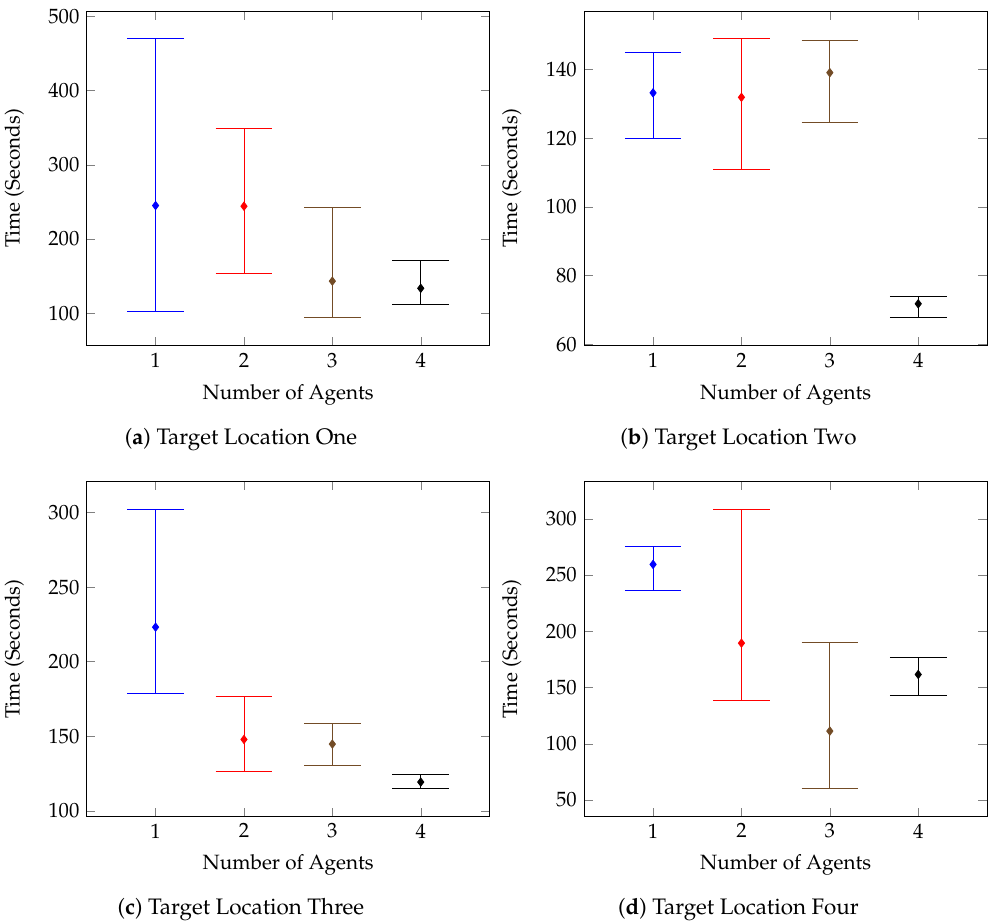
Figure 14. Number of Agents vs. Maximum, Mean and Minimum Times (Seconds)-Test Environment